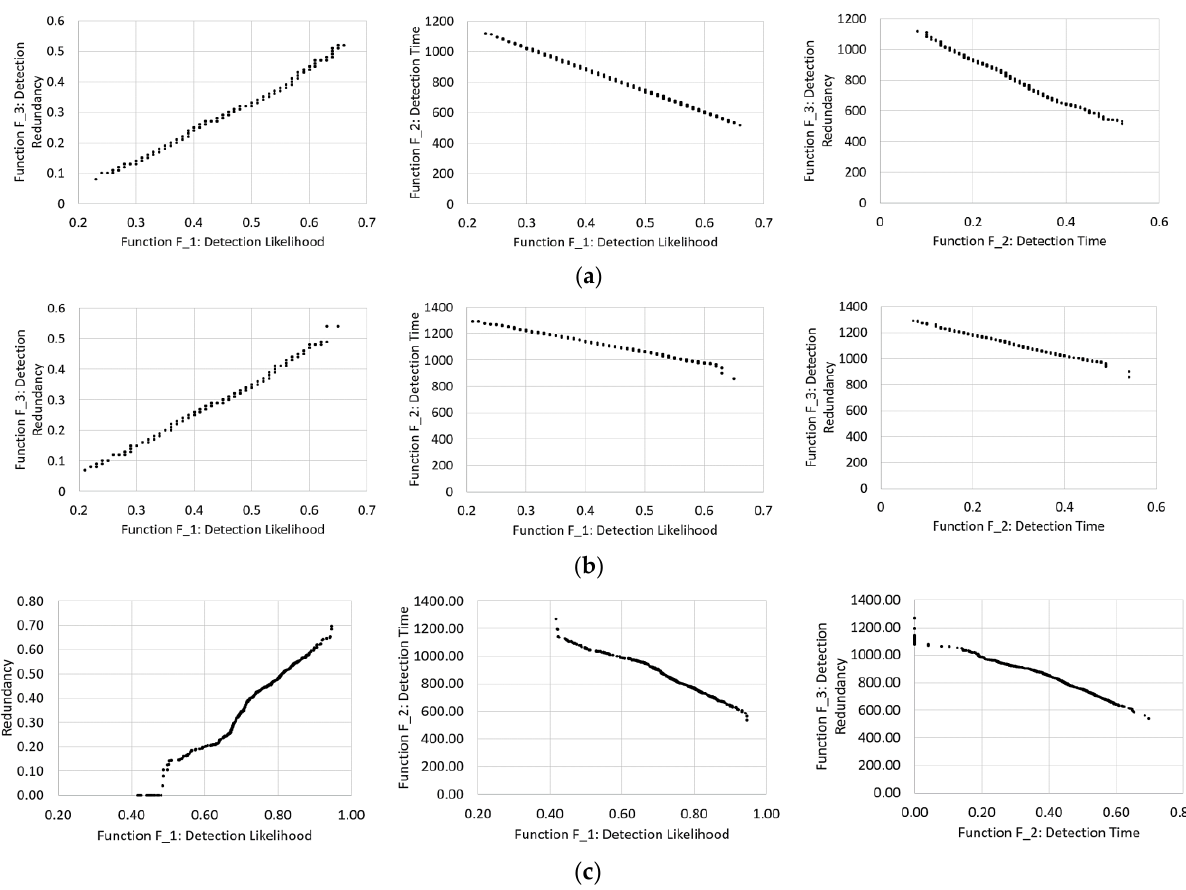
Figure 5. The Pareto front, including only advection (row a ), dispersion (AZRED by Romero-Gomez and Choi 2011, row b ), and dispersion (EPANET-DD) (row c ): F_1 – F_3 (left), F_1 – F_2 (centre), and and Choi 2011, row ( b )), and dispersion (EPANET-DD) (row ( c )): F_1–F_3 (left), F_1–F_2 (centre), and F_2 – F_3 (right). F_2–F_3 Table 1. Numerical analysis: Results of the Optimisation Problem.